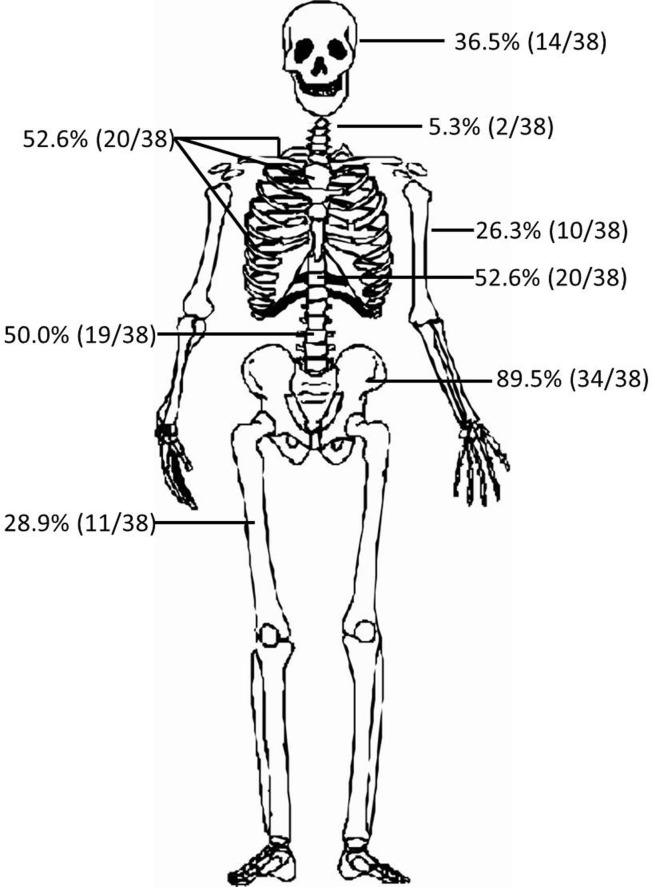
Distribution of bone lesions in POEMS syndrome.The pelvis was the most commonly affected region, followed by spine, clavicle/scapula/sternum/ribs, cranium, and long bones (humeri and femora). Percentages of patients with affected cranium, cervical spine, and long bones were based on the SS; the others were based on CT images.